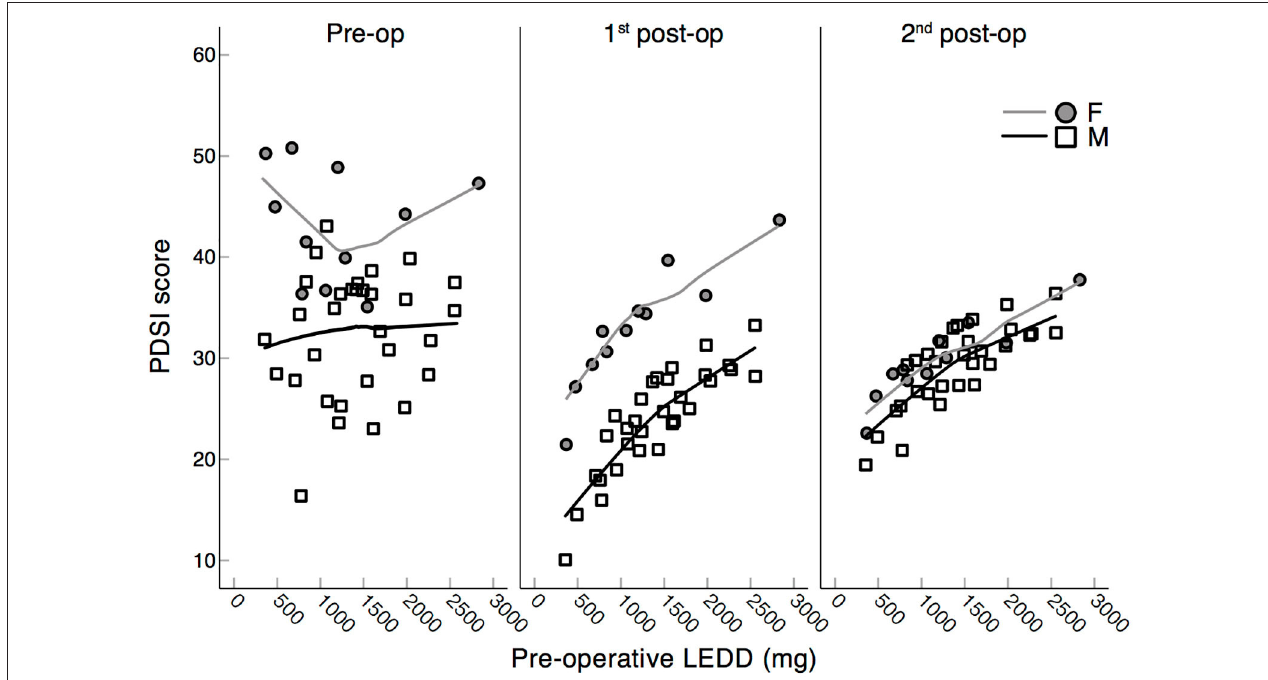
FIGURE 6 | Scatter plots of PDSI scores (PDQ-39) and pre-operative LEDDs. Assessment of scores in PD patients at the three experimental stages: pre-operation, 1st post-operation, 2nd post-operation separated by sex: F = female, M = male. Higher PDSI scores correspond to a worse QoL. Lines represent Loess fit lines with 99% proportion of data points and Epanechnicov’s kernel